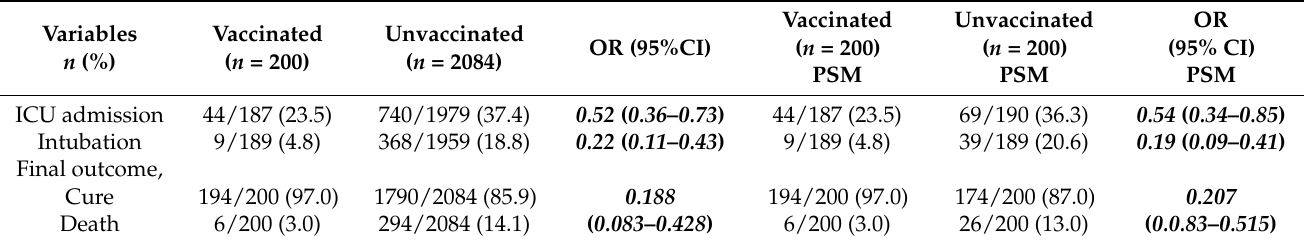
Table 3. Characteristics of COVID-19 outcomes according to vaccination status, overall and after propensity score